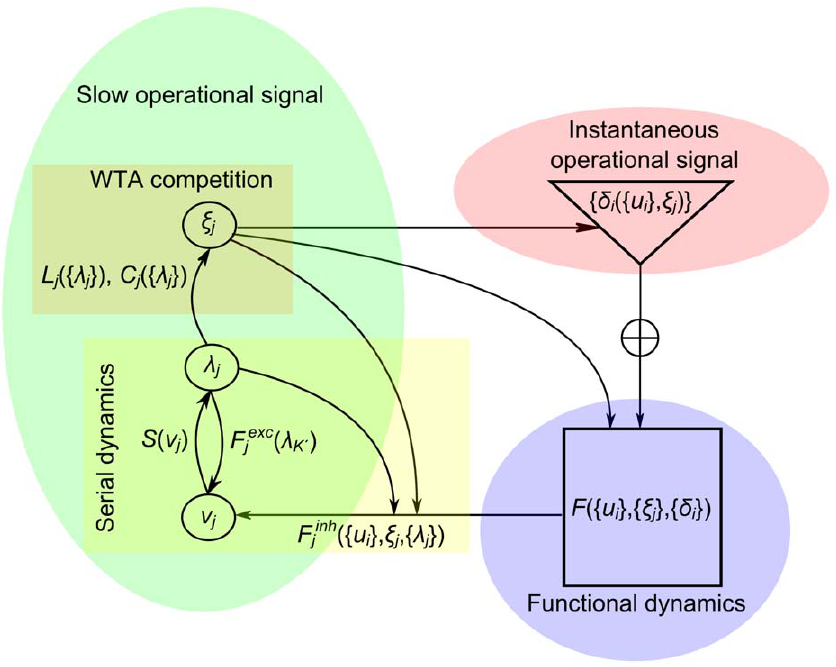
Figure 3. Interactions among the functional architecture ’ s components. The functional dynamics F ({ u i },{ j j },{ d i }) is fed back to the slow serial dynamics by means of inhibitory feedback, F inh ({ u i }, j j ,{ l j }), and is integrated by the feedback integrating variable v j . v j causes timely fast transitions to the ‘ switching ’ variable l j to which it is coupled via the sigmoidal function S ( v j ) and excitatory feedback F exc ( l K’ ). l s regulate the WTA competition of the { j j } (via L j ({ l j }) and C j ({ l j })) that determine which functional mode will dominate the expressed phase flow F ({ u i },{ j j },{ d i }) at each time moment. The instantaneous operational signal { d i ({ u i },{ j j })} also receives feedback from output { u i } and is also coupled to the { j j }. Thus, the whole functional architecture becomes an autonomous system. (The index j [ J K ’ v K runs among the K 9 modes that participate in a sequence J out of a repertoire of K modes, and also indicates the specific order of the sequence, i.e., the sequence starts with mode with j =1 and terminates with j = K 9 . The index i runs among the dimensions of the state variables).